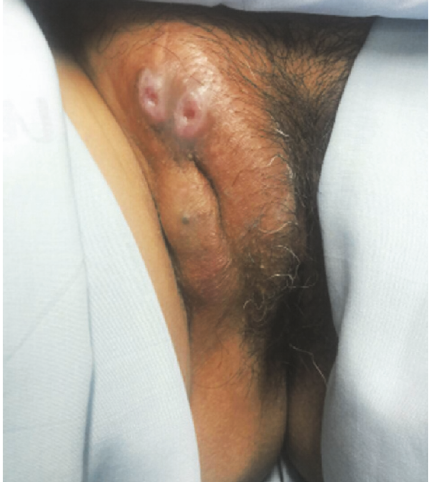
Figure 3: A hard consistency mass at the right labia majora extending to the right groin with